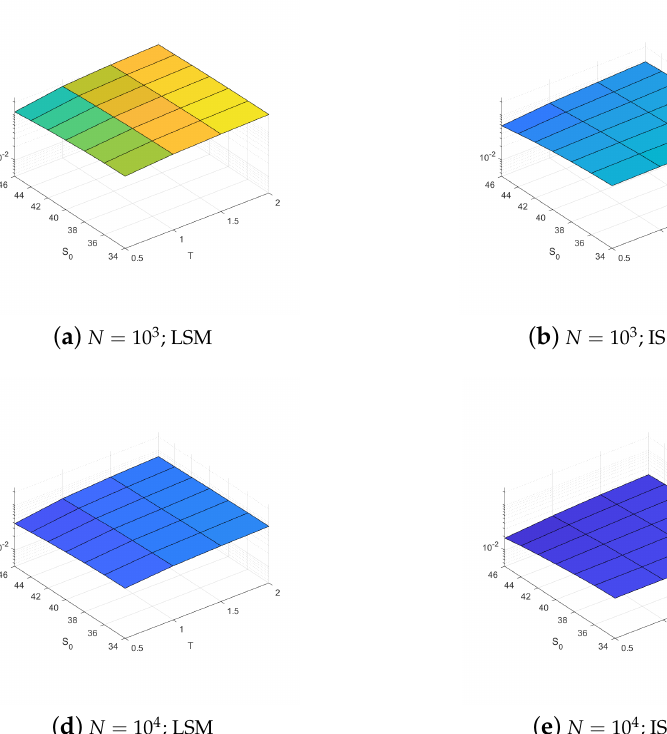
Figure 7. Standard deviation without and with GHS drift. Standard deviation results are calculated from a sample of R = 10 7 / N replications of the LSM and the LSM-s estimators. The left column illustrates results for the LSM without importance sampling, the center column LSM with importance sampling, and the right column LSM-s with importance sampling. The top row presents results for estimators using 1000 paths and the bottom row for 10,000